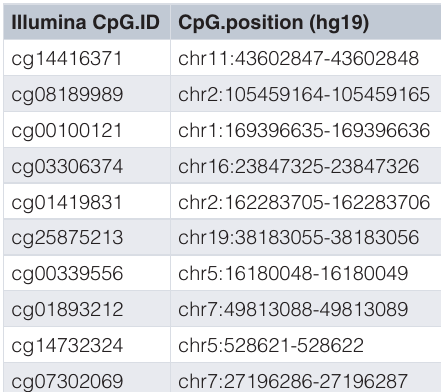
Table 1. List of 10 DNA methylation biomarker loci used in the study. The first column specifies Illumina CpG probe and the second column shows the genomic position of each biomarker